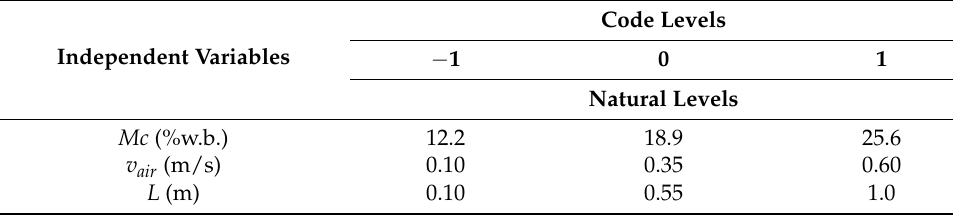
Table 2. Experimental design for the RSM